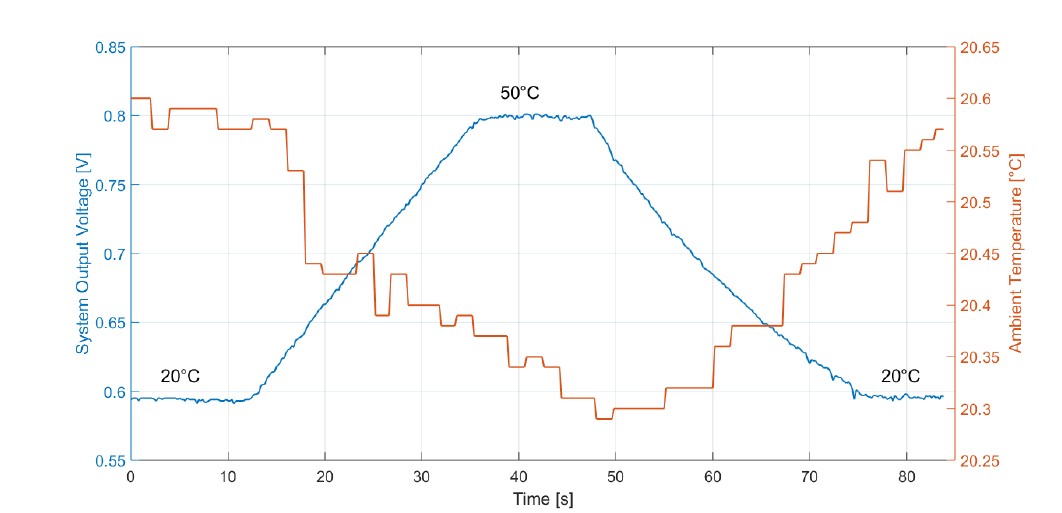
Figure 8. Measured thermopile sensor-interface circuit system output with the black body at 10-cm distance and the ambient temperature at 20 ◦ C. The black body temperature is varied in ramp fashion from 20 ◦ C to 50 ◦ C. The buffer offset was not subtracted from the output signal.